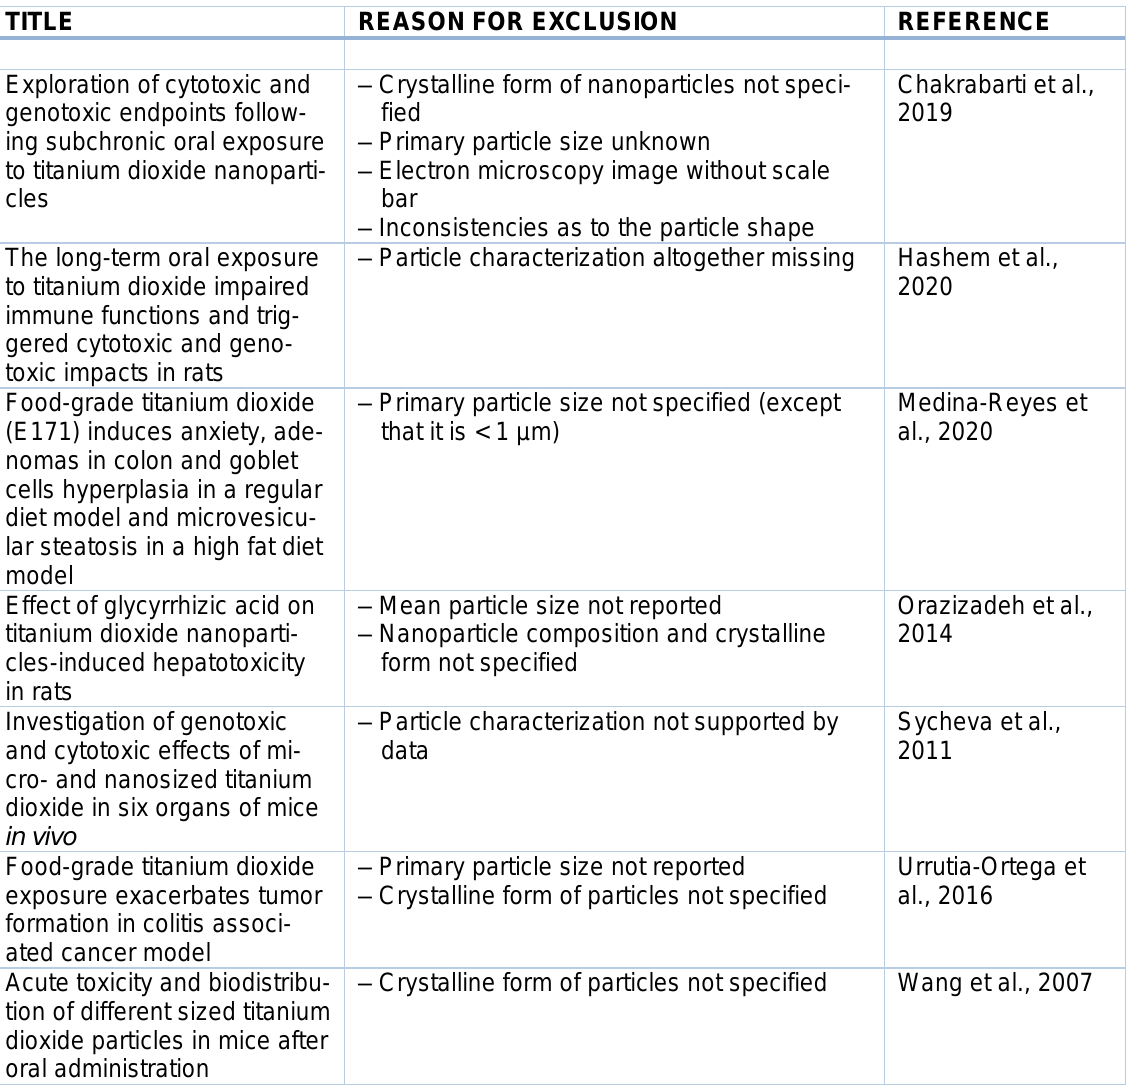
Table 1: Studies related to the safety of TiO 2 materials not considered in this review due to incomplete particle